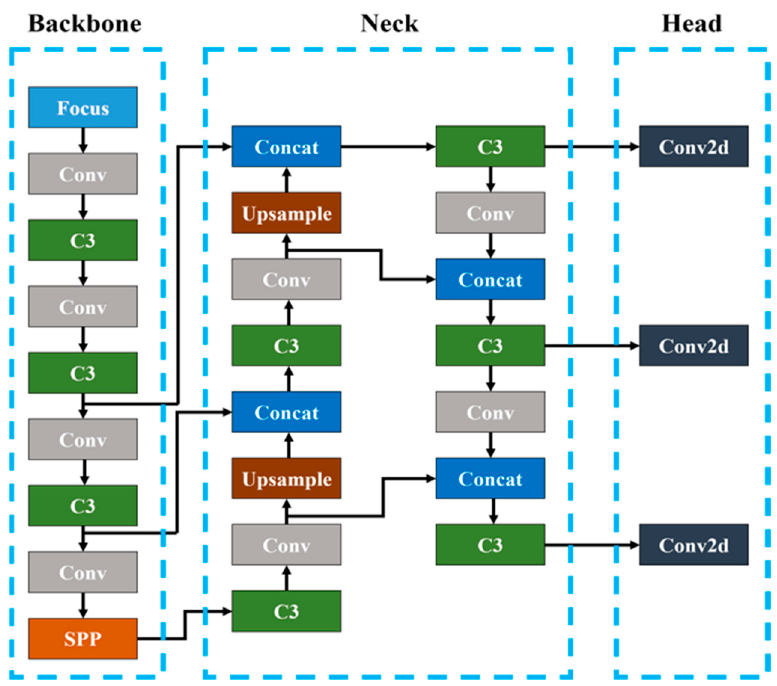
Figure 5. YOLOv5 network structure.